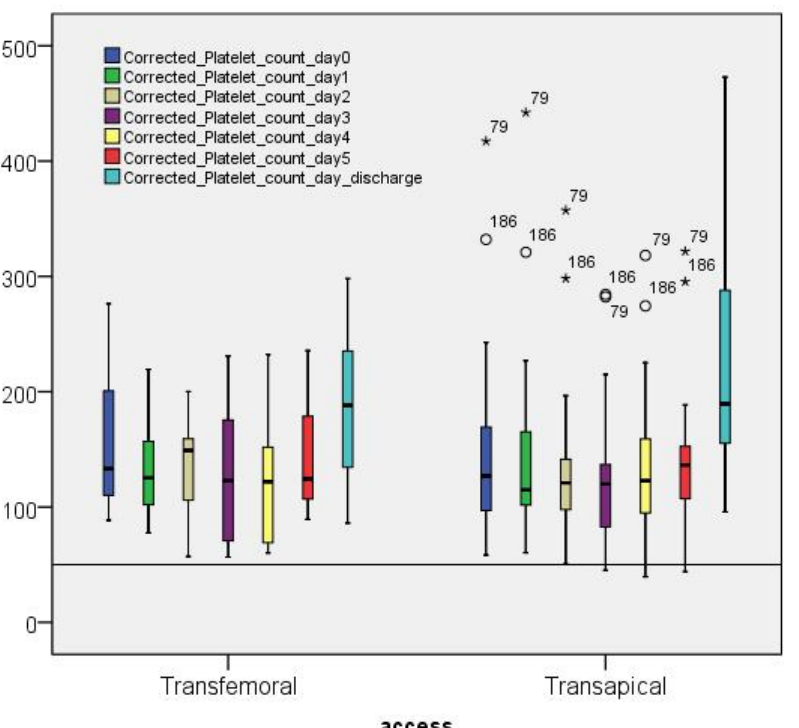
Figure 4. Bar chart showing the distribution of mild (MT) and severe (ST) thrombocytopenia accord- ing to implanted prosthesis. Asterisk and circles show outliners.